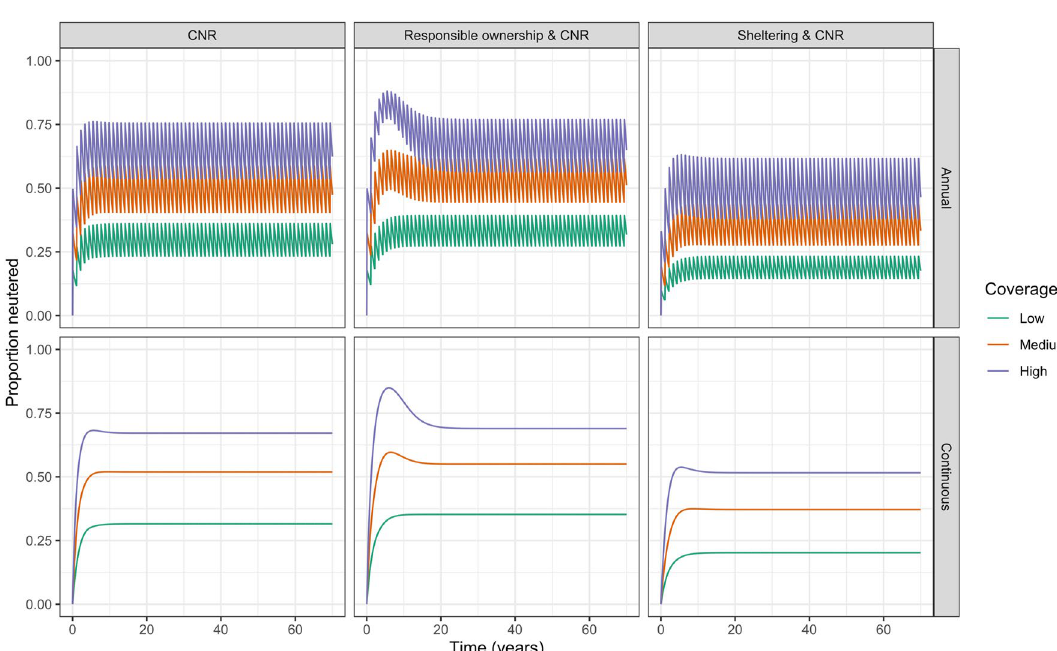
Figure 3. Proportion of free-roaming dogs neutered for interventions including CNR and applied for duration of the simulation at low, medium, and high coverages applied annually and